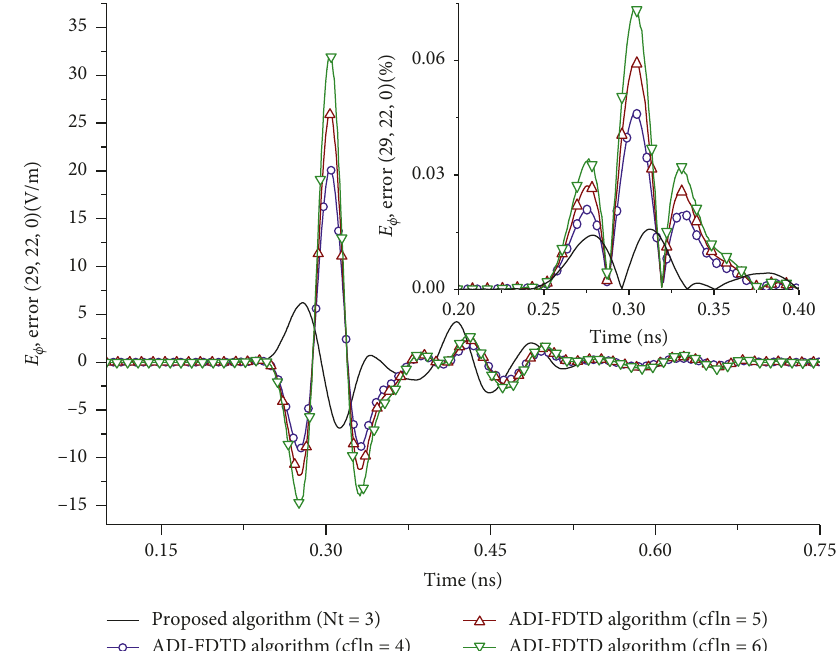
Figure 8: Errors obtained by E